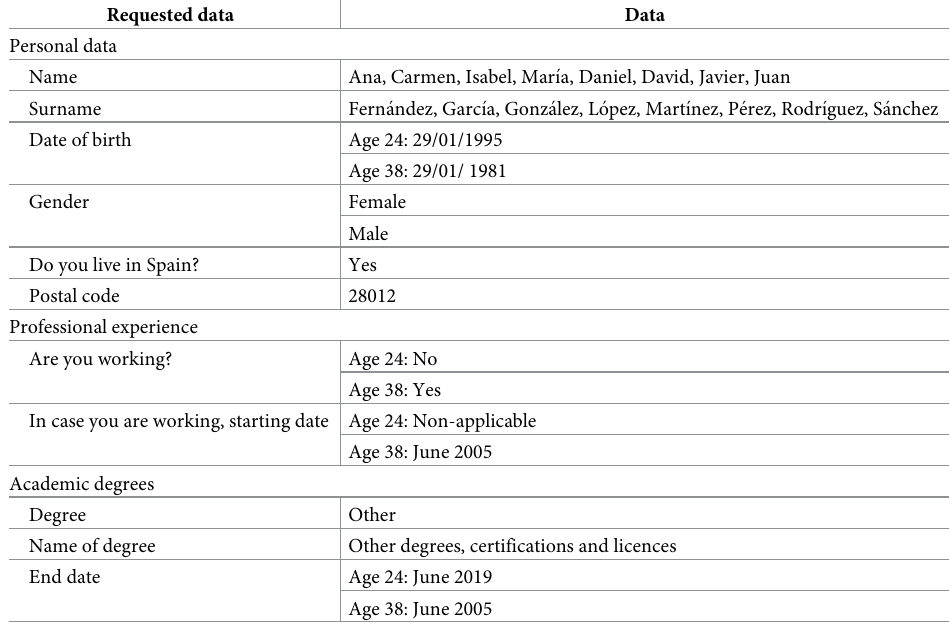
Table 1. Data that we entered during the registration process of the eight matched